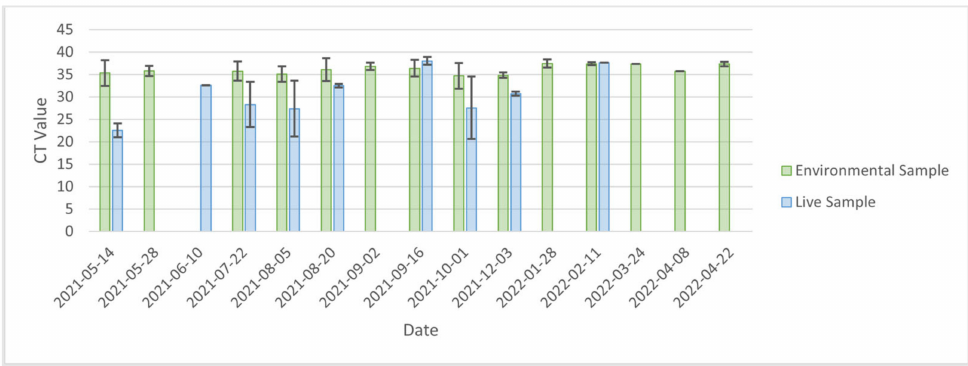
Figure 2. Comparison of average CT values for environmental and live animal samples. No live samples occurred after 2022-02-11 because the farm was